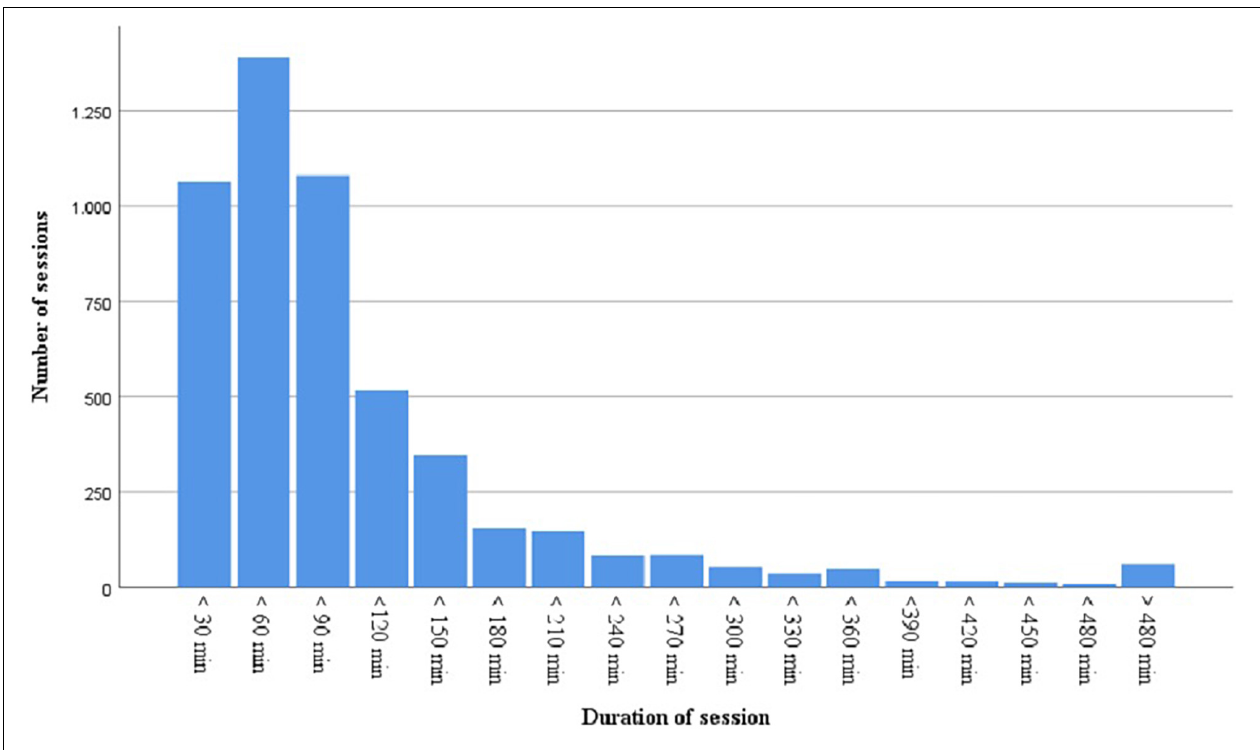
FIGURE 7 | The number of sessions of a certain